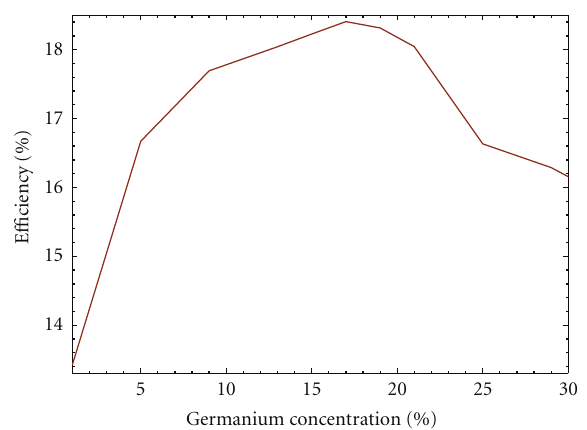
Figure 9: The a-SiGe:H solar cell e ffi ciency as a function of Ge concentration in SiGe layer.